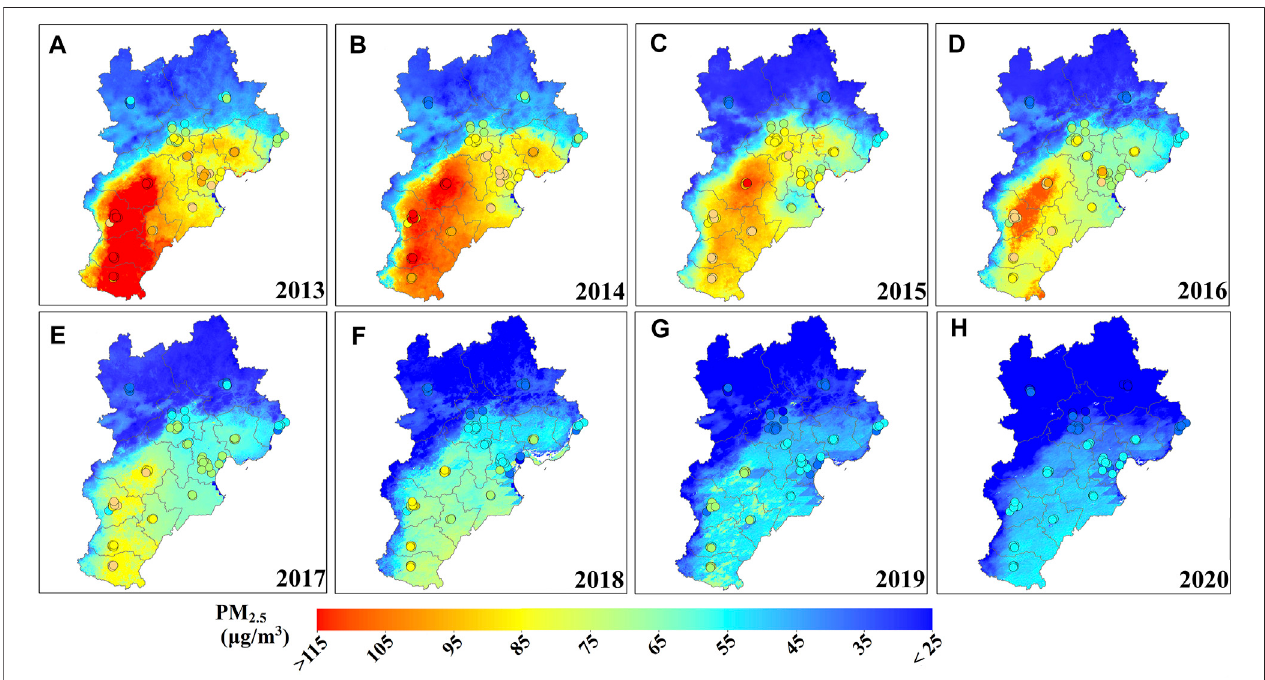
FIGURE 5 | The distribution of the annual mean estimated PM 2.5 concentrations and observed PM 2.5 concentrations in the Beijing – Tianjin – Hebei region during 2013 – 2020 (A – H) .